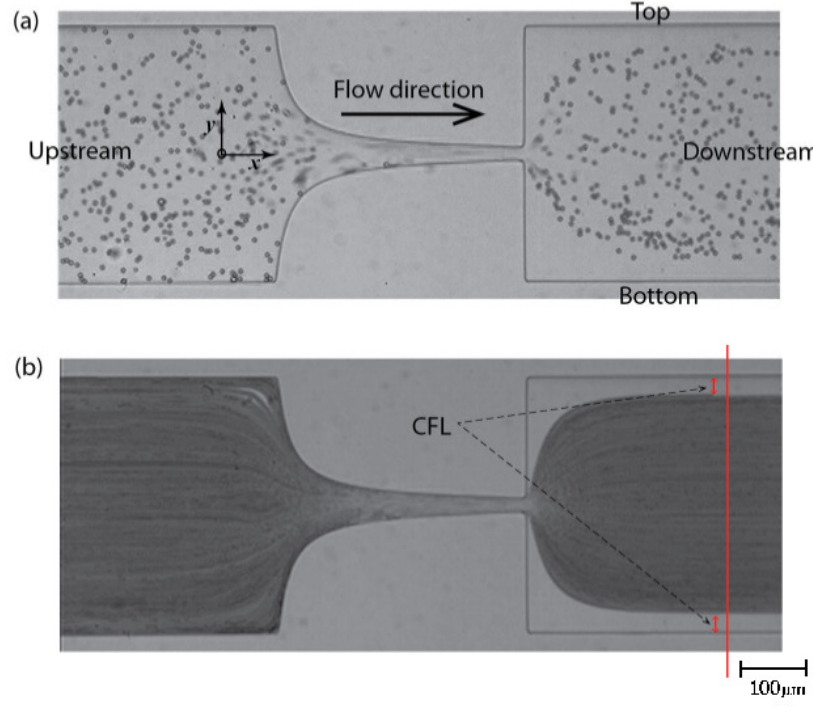
Figure 3. ( a ) An original image of polymethylmethacrylate (PMMA) particle flow and ( b ) its minimum intensity image; the vertical line is the measuring position placed at 300 µm from the contraction